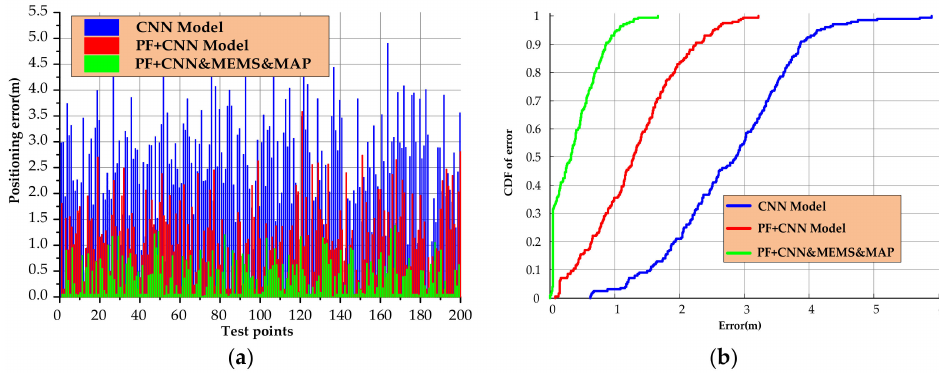
Figure 14. Error analysis of positioning results: ( a ) positioning error and ( b ) cumulative distribution function of error.